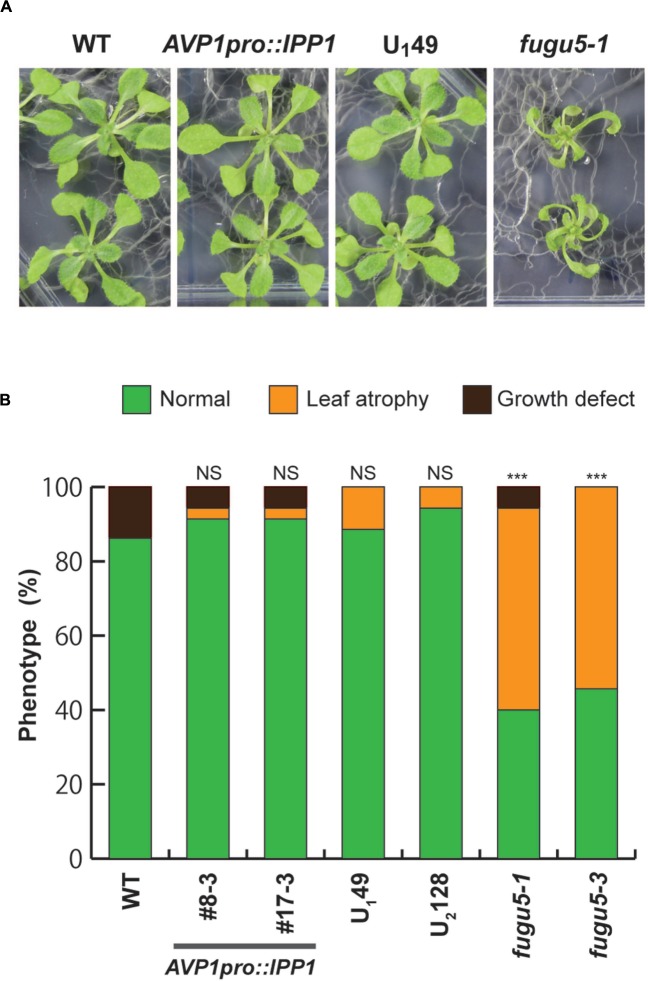
Leaf atrophy and necrotic symptoms are rescued by the introduction of yeast-soluble PPase and the uncoupling-type H+-PPase into fugu5 mutants.
(A) Yeast-soluble PPase (IPP1) (Ferjani et al., 2011) and the uncoupling variants of Arabidopsis H+-PPase (U149 and U2128) (Asaoka et al., 2016) were introduced to fugu5-1 and fugu5-3, respectively, under the control of the AVP1 promoter. Plants were grown on MGRL plates for 3 weeks before being photographed. (B) WT, fugu5-1, fugu5-3 and transgenic plants were grown on MGRL plates for 3 weeks. Phenotypic distribution: normal plants (green), plants with leaf atrophy (dark yellow), and plants with growth defects (dark brown). The frequencies of these phenotypes are shown (n = 25). Asterisks indicate significant differences at ∗∗∗P < 0.001 compared with plants grown on MGRL plates (Pearson’s chi-squared test). NS, not significant.